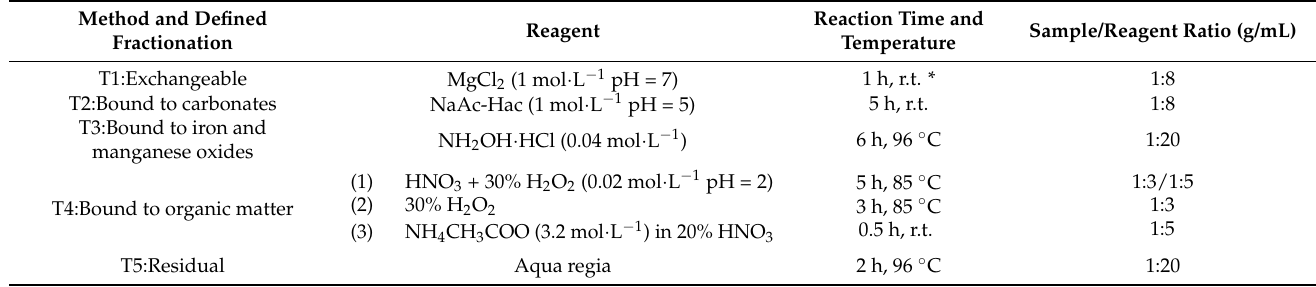
Table 2. The sequential extraction procedure of the Tessier (modified)